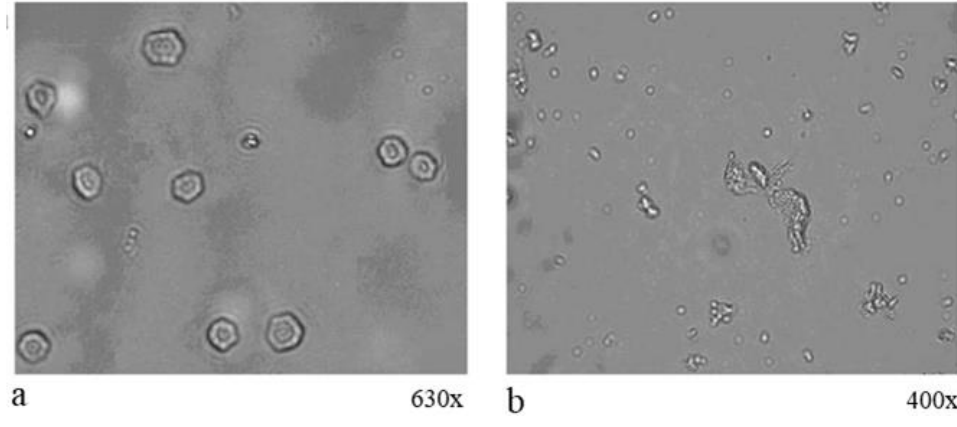
Figure 4. Optical micrographs exhibiting BS micro-encapsulation in polymers with magnification Optical micrographs exhibiting BS micro-encapsulation in polymers with ×630 ( a ), and magnification ×400 ( b ) [81]. magnification × 630 ( a ), and magnification × 400 ( b ) [81]. Table 5. Thermo-physical properties of different butyl stearate